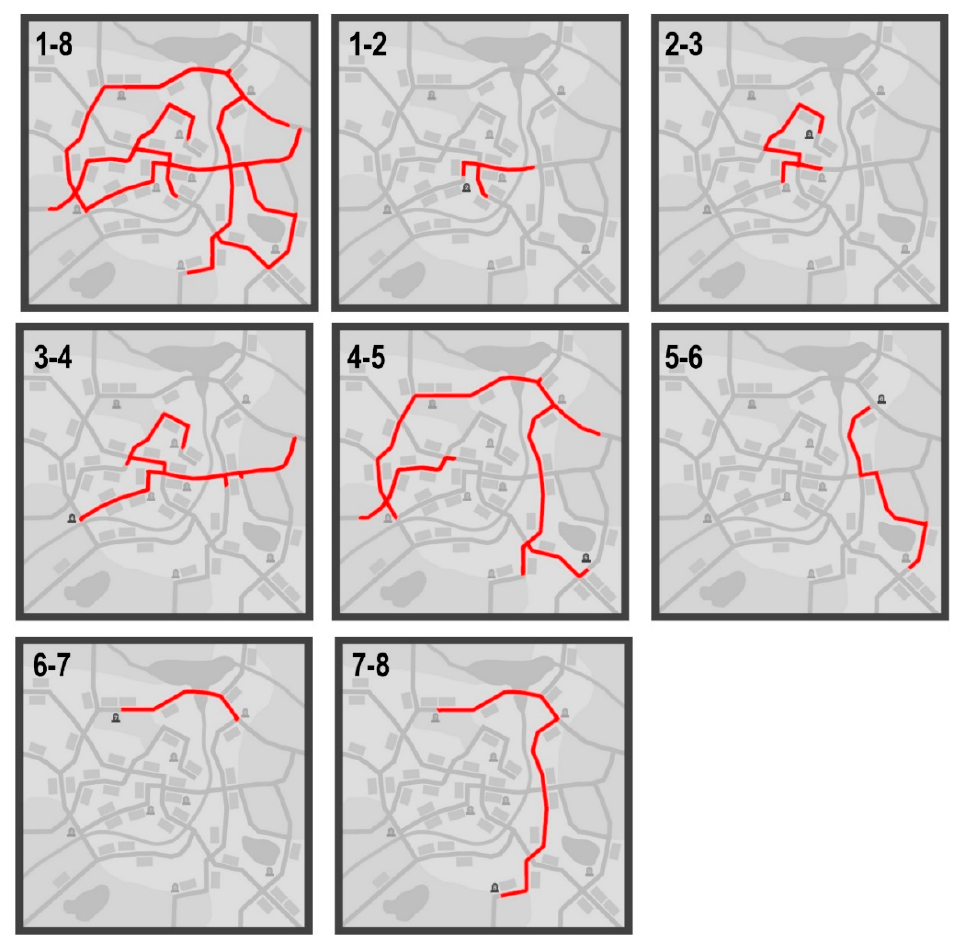
Figure 5. Path data of participant no. P18 (see Figure 6) .